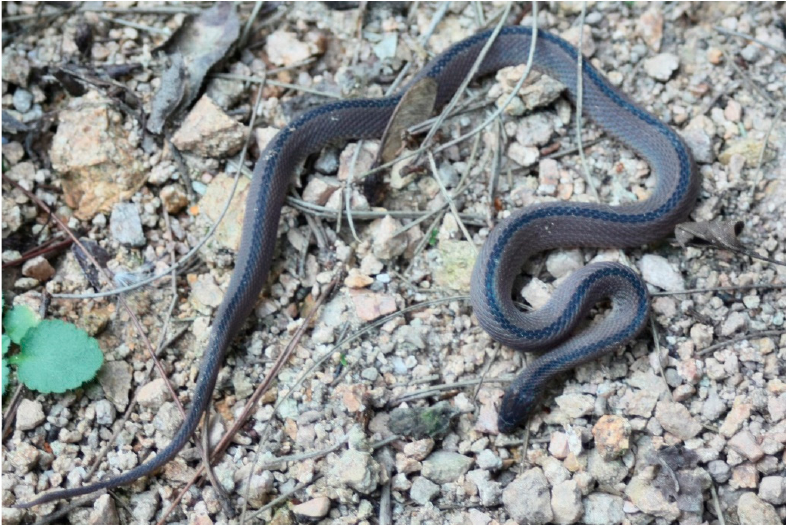
Figure 2. General view of the holotype of Achalinus dabieshanensis sp. nov. in life (Photography by Kai Zhao). Table 3. Measurements, scale counts, body proportions, and squamae characters of the sample of Achalinus dabieshanensis sp. nov.